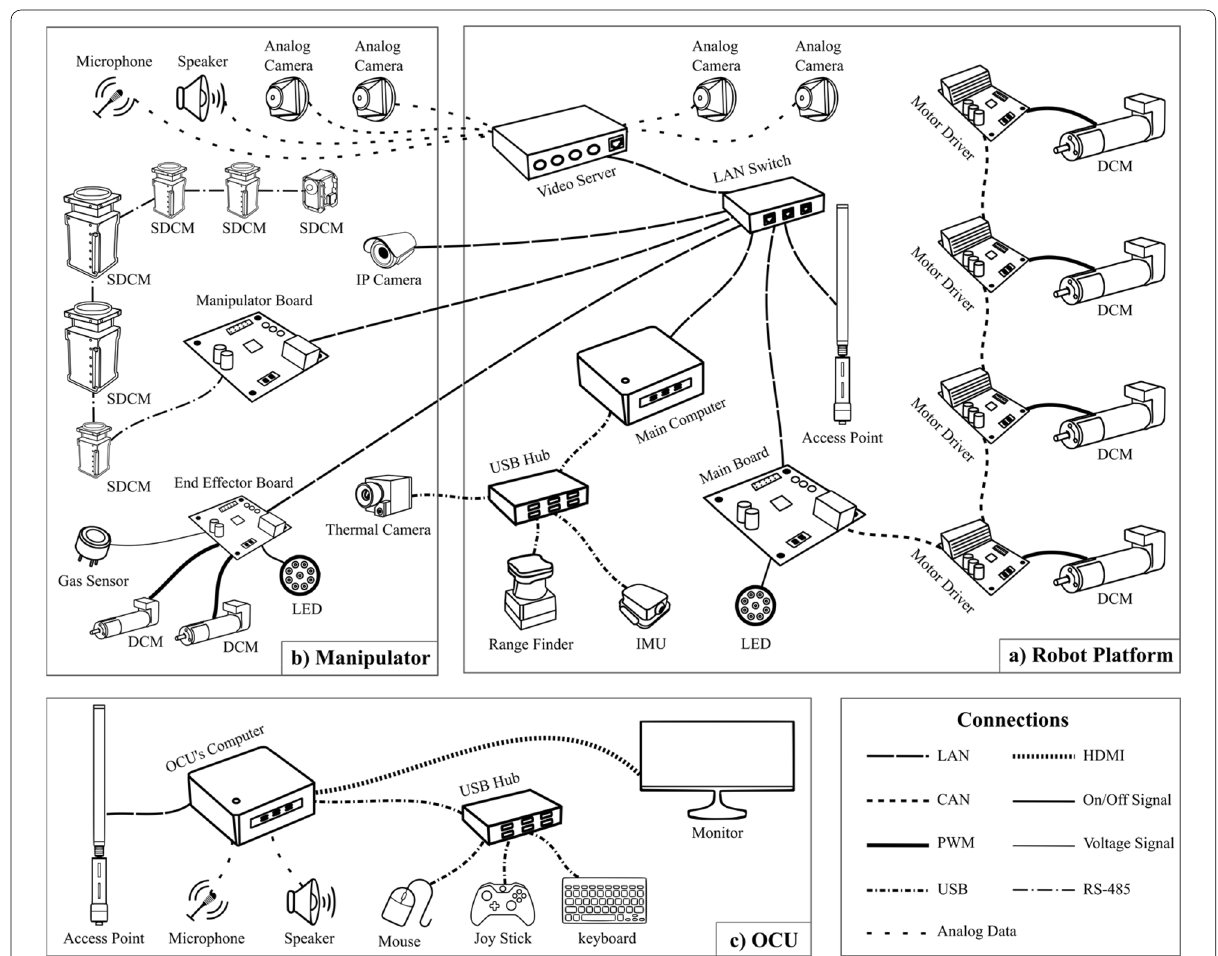
Fig. 13 The block diagram of the command and control system. For the sake of simplicity, all connections involving power distribution have been